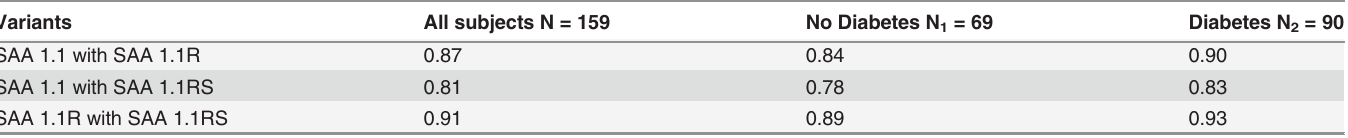
Table 6. Correlations between SAA 1.1 variants in diabetes